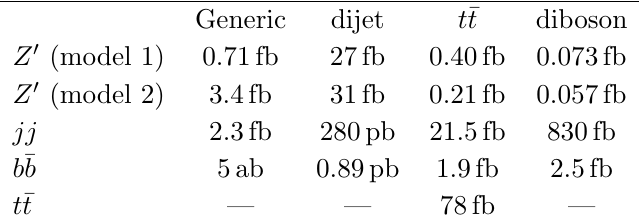
Table 3 . Signal and background cross sections for the Z 0 signal in scenario 1 and main SM backgrounds (in rows) under the four di(cid:11)erent event selections for generic, dijet, t (cid:22) t and diboson resonance searches, in